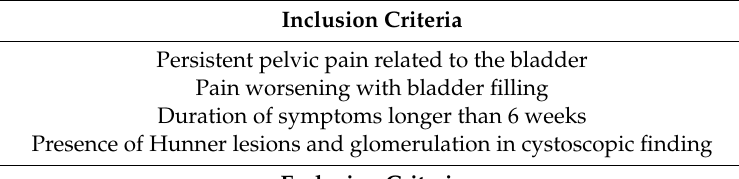
Table 1. Inclusion and exclusion criteria of the study population.